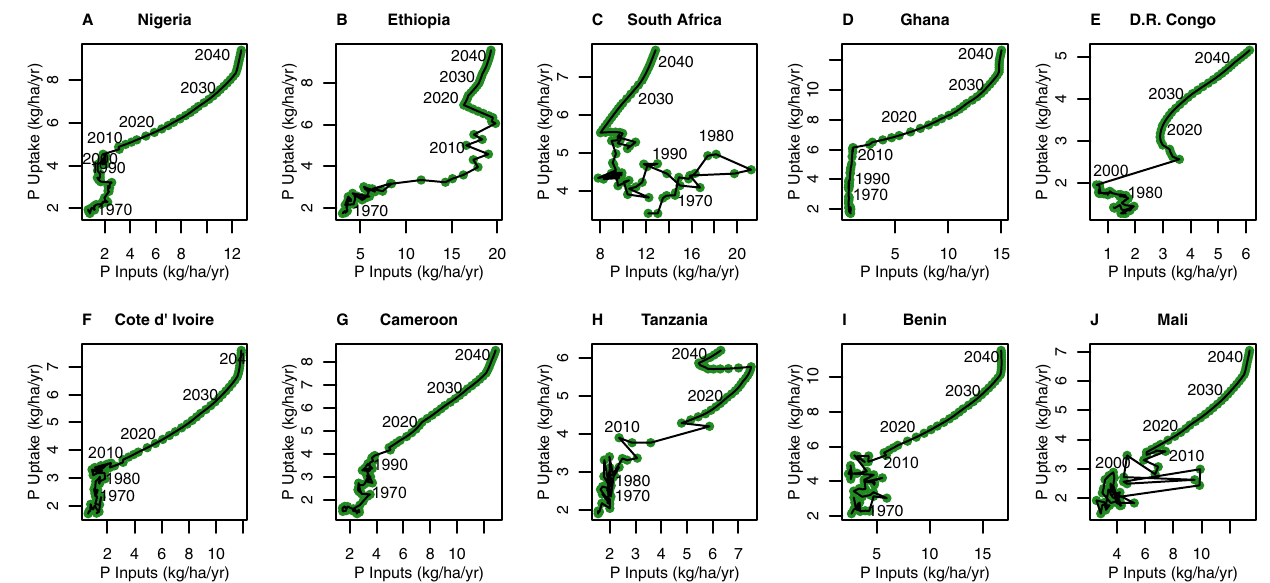
Fig. 5 | Historical trend between the phosphorus application and uptake in different Sub-Saharan African countries. Total phosphorus inputs (fertiliser and